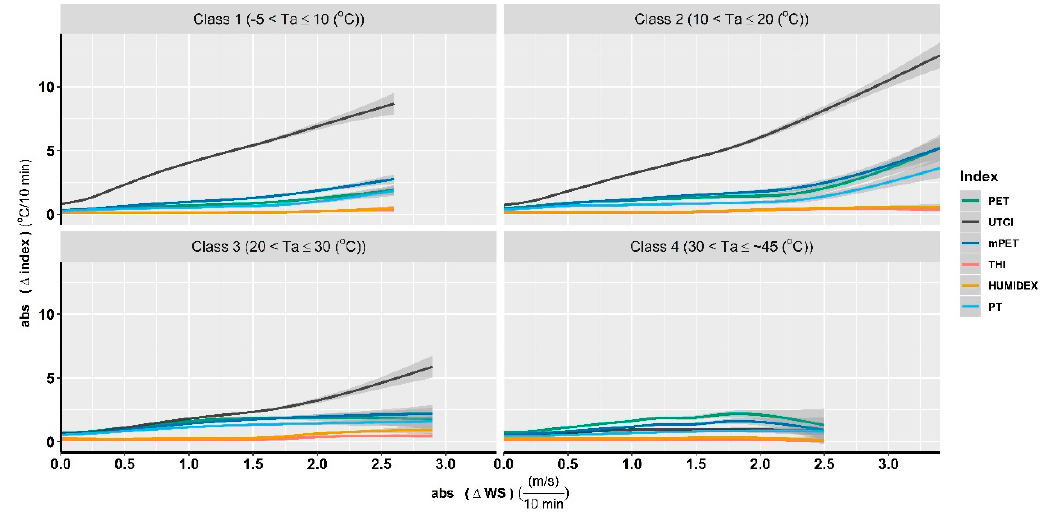
Figure 12. The sensitivity of the indices to wind speed (WS) variation under different air temperature (T a ) conditions.